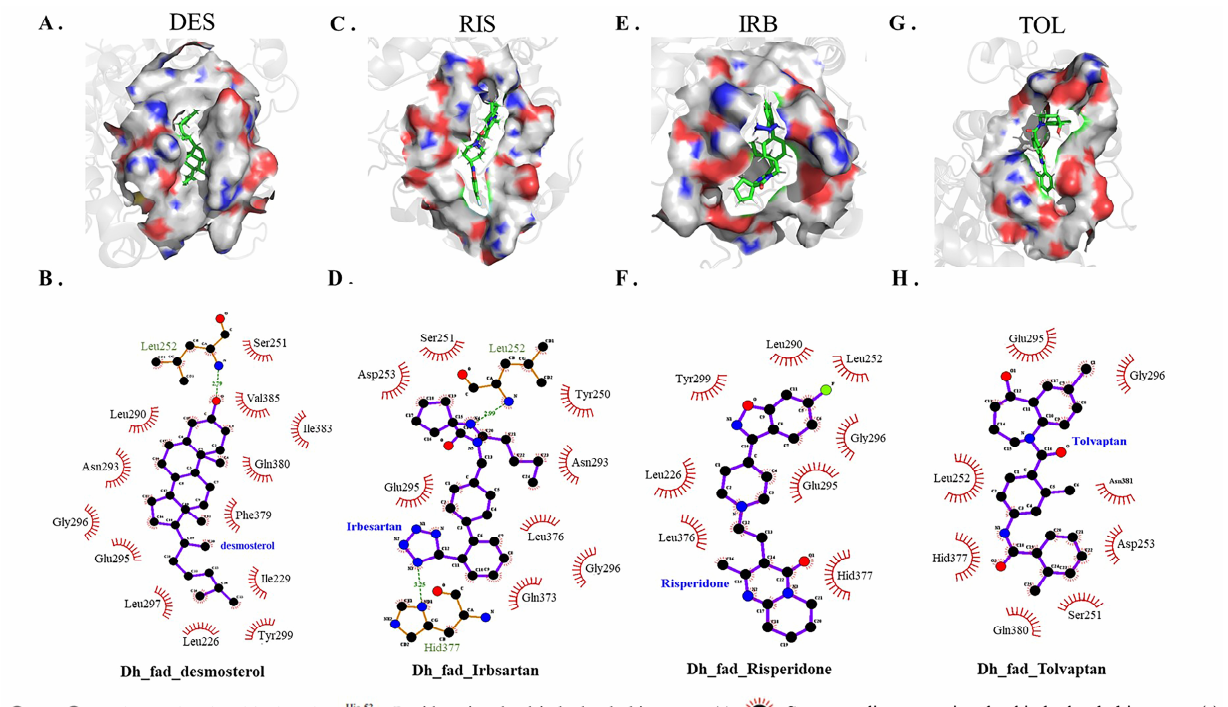
Figure 3. Atomic interaction of desmosterol and three inhibitors with DHCR24 . ( A , C , E , G ) Hydrogen and hydrophobic interactions as plotted by LIGPLOT. Desmosterol, irbesartan, risperidone and tolvaptan are indicated in blue font. ( B , D , F , H ) The key amino acid residues(green) participated in the binding interaction with inhibitors. DES is desmosterol; RIS is risperidone; IRB is irbesartan; TOL is tolvaptan.